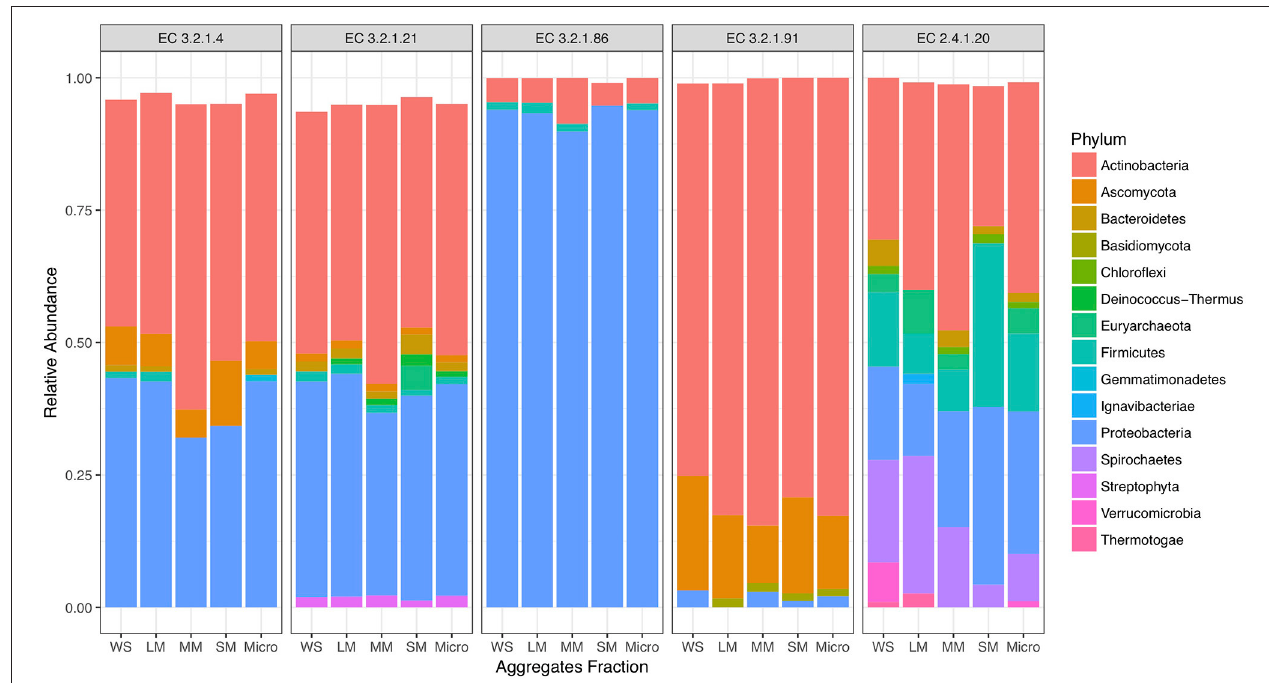
FIGURE 2 | Proportion of taxonomy associated with cellulose decomposition enzymes including endoglucanases (EC 3.2.1.4), β -glucosidases (EC 3.2.1.21), 6-phospho- β -glucosidase (EC 3.2.1.86), cellobiose phosphorylase (EC 2.4.1.20), and cellobiohydrolases (EC 3.2.1.91) in fertilized prairie aggregate metagenomes.